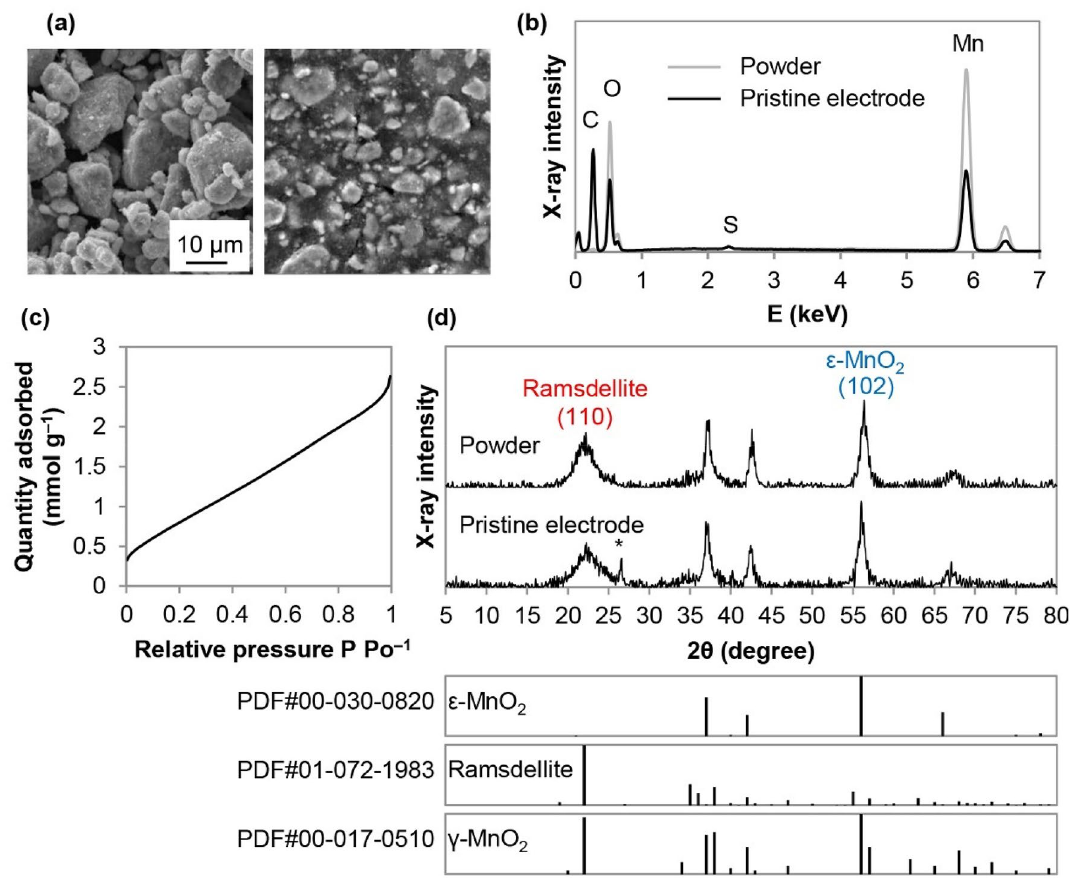
Figure 1. ( a ) SEM secondary electron (SE) images of the EMD powder (LHS) and pristine EMD electrode (RHS). ( b ) EDX spectra from the entire image areas shown in ( a ). ( c ) Nitrogen adsorption isotherm for the EMD powder. ( d ) XRD patterns, along with powder diffraction files (PDFs) for ε-MnO 2 , ramsdellite, and γ-MnO 2 . The asterisk indicates a graphite peak from the current